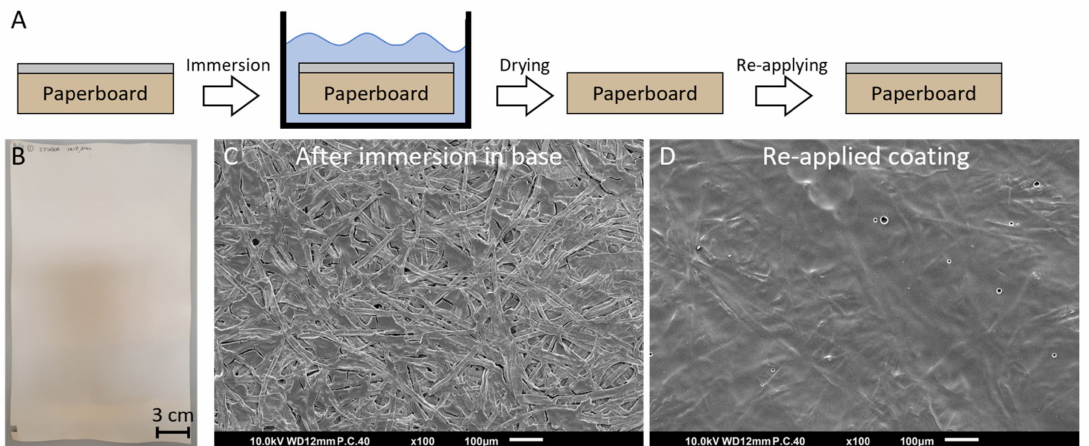
Figure 7. ( A ) Schematic representation of the base treatment by immersing the coated paperboard in 0.1 M NaOH for 5 min and subsequently extensive rinsing with demineralized water. After drying the treated paperboard under vacuum overnight, a new coating layer was re-applied on the paperboard. ( B ) Photograph and ( C ) SEM image of the coated paperboard was immersed in 0.1 M NaOH solution for 5 min and dried in vacuum overnight. Subsequently, ( D ) SEM image after applying a new coating layer on the base-treated